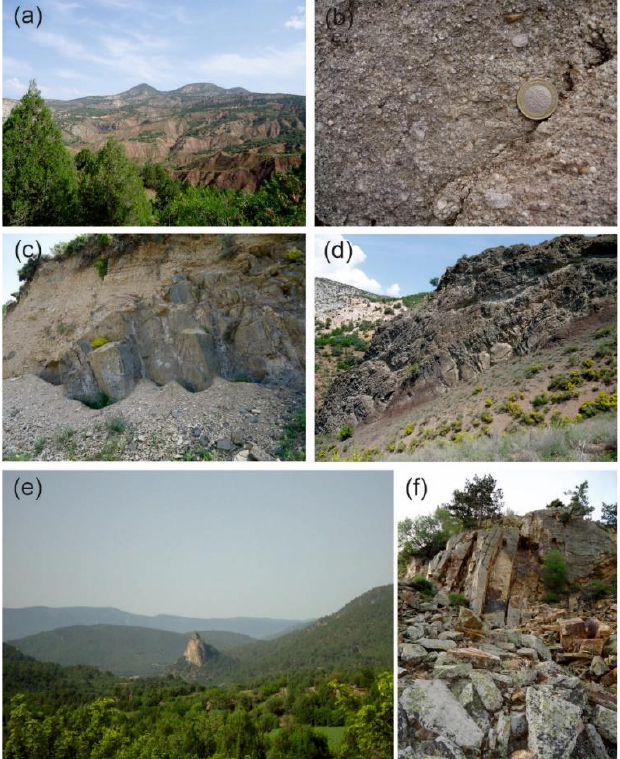
Figure 3. ( a ) Continental red beds of the Kızılçay Formation which unconformably overlay the basement units. ( b ) Nummulite-bearing sandstone levels of the Güvenç Formation. ( c ) Columnar joints in basaltic lavas. ( d ) General view of the flow deposits and lava flow alternations. ( e ) General view of the rhyolitic-dacitic plug of the SNV. ( f ) Close-up view of the rhyolitic-dacitic unit in the Sarıcakaya–Nallıhan Basin. The rhyolitic–dacitic unit also shows common columnar jointing. Basaltic, and andesitic lavas display black to reddish colors, columnar jointing and flow bending in their outcrops and contain plagioclase, clinopyroxene, olivine, and hornblende with volcanic glass that can be detected by the naked eye in hand specimens. Dacitic